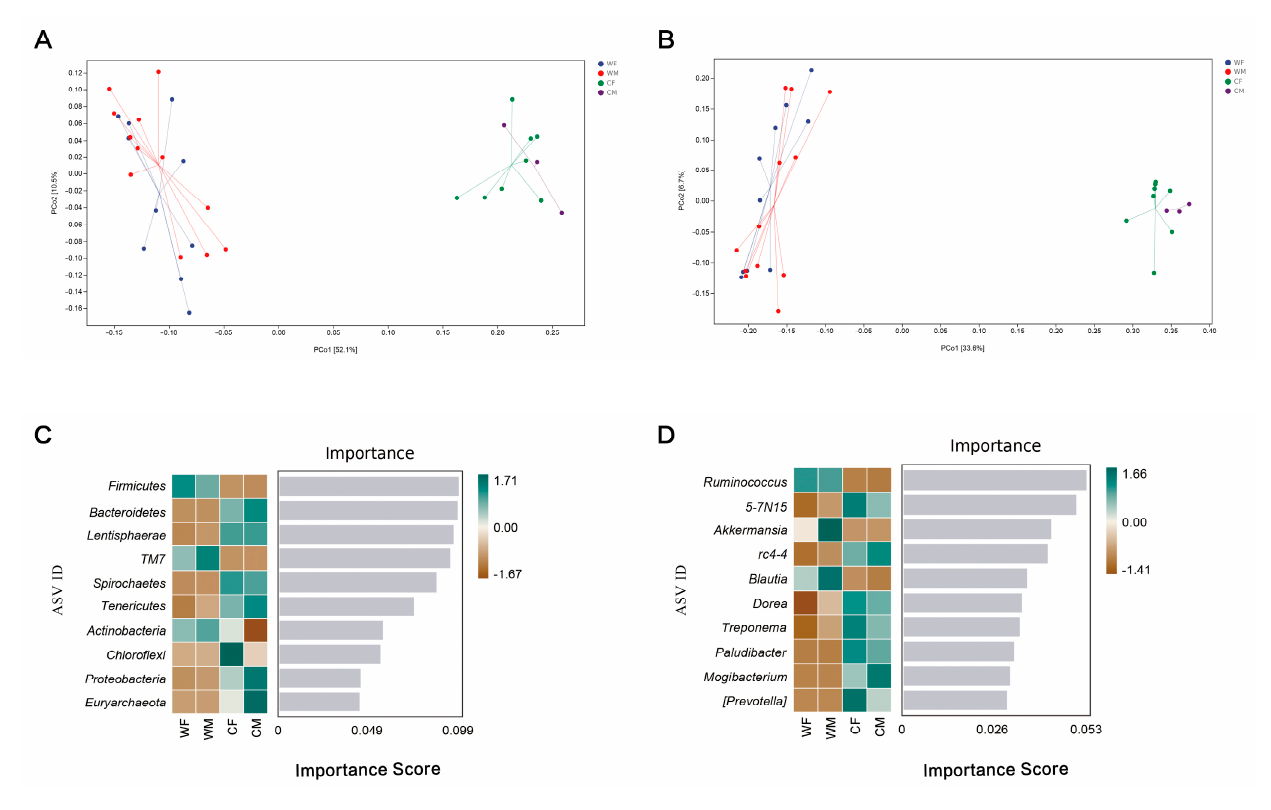
Figure 3. Faecal microbial structure of red deer. ( A ) Principal Coordinate Analysis based on weighted unifrac showing microbial samples clustered by sex and environment into different groups (in parenthesis, the explained variance of each axis; WF: wild female; WM: wild male; CF: captivity female; CM: captivity male). ( B ) Principal Coordinate Analysis based on unweighted unifrac showing microbial samples clustered by sex and environment into different groups (in parenthesis, the explained variance of each axis; WF: wild female; WM: wild male; CF: captivity female; CM: captivity male). ( C ) A random forest heatmap indicating intergroup differences at the phylum level. Importance means screening the most critical phylum or genus that leads to microbial structural differences between groups (WF, WM, CF, CM). ( D ) A random forest heatmap indicating intergroup differences at the genus level (WF: n = 10, WM: n = 12, CF: n = 8, CM: n = 3).